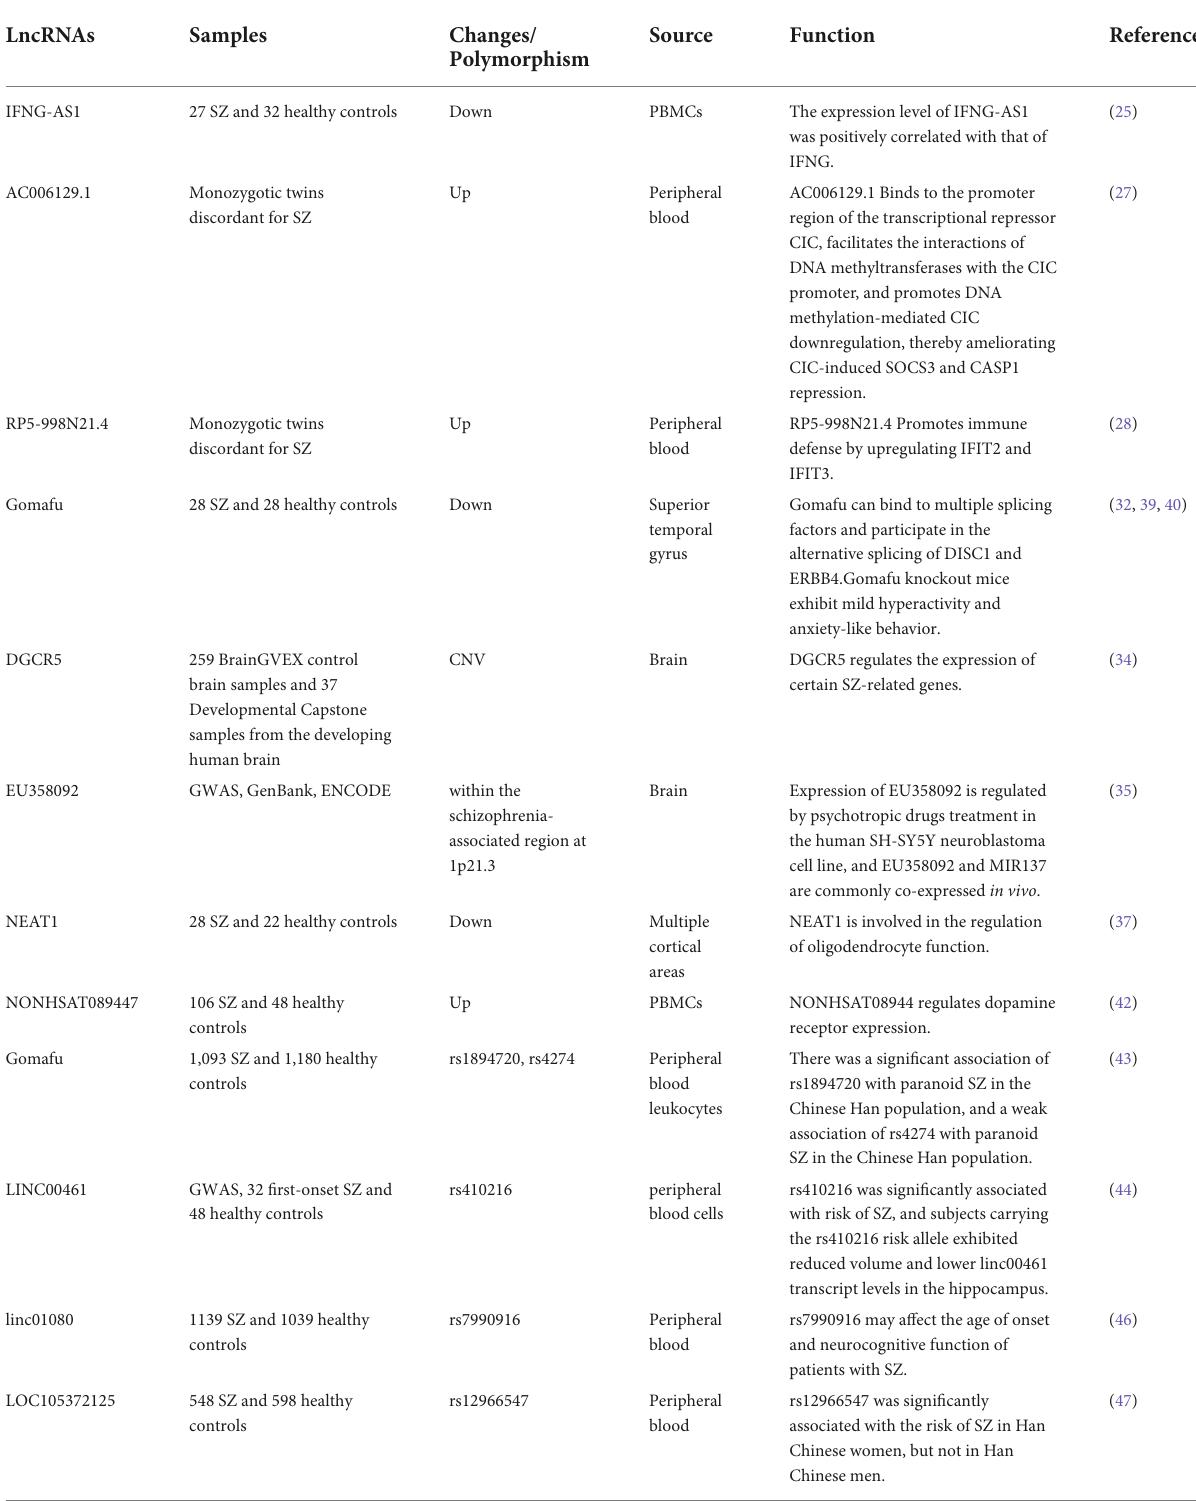
TABLE 1 Studies that investigated the role of lncRNAs in